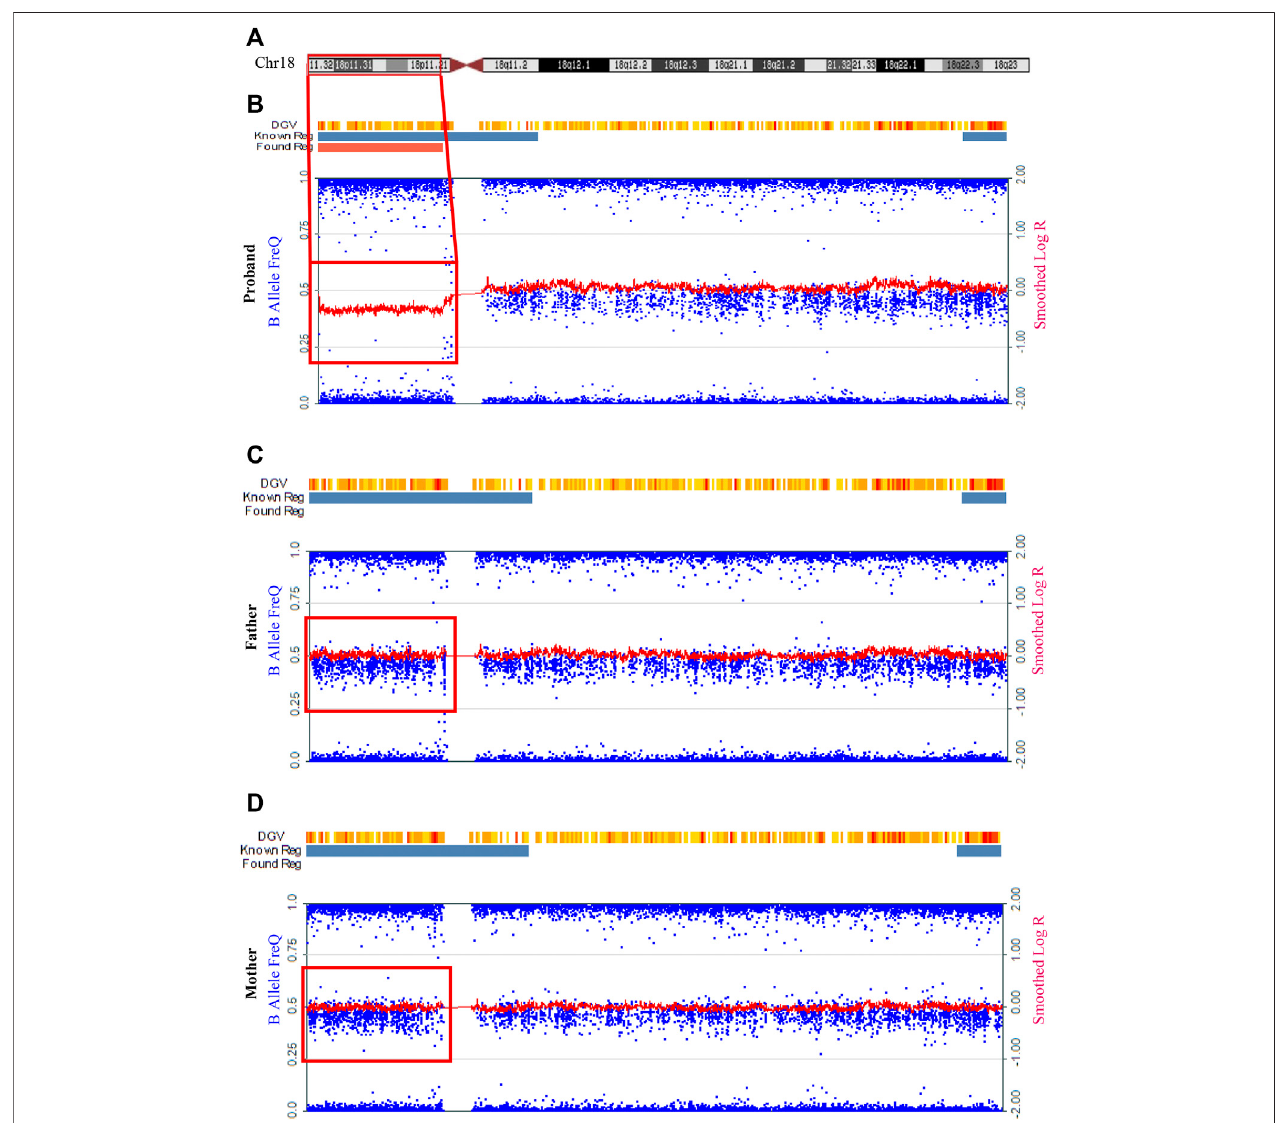
FIGURE2| Detectionofa14.3 Mbpheterozygousdeletionatchromosome18p11.32-p11.21bySNParrayintheSMMCIpatient. (A) Schematicrepresentationof the chromosome 18. (B – D) Analysis of the peripheral blood on the In fi nium Global Screening Array for the proband (B) , his father (C) and his mother (D) . The red frame indicated the region of chromosome deletion. Blue dots represented “ B allele frequency. ” Red lines represented “ log R ratio. ” DGV, Database of Genomic Variants. Known reg and blue bar represented known regions in DGV. Found reg was the abnormal CNV found by the software-red bar represented deletion, green bar represented duplication, and gray bar represented the loss of